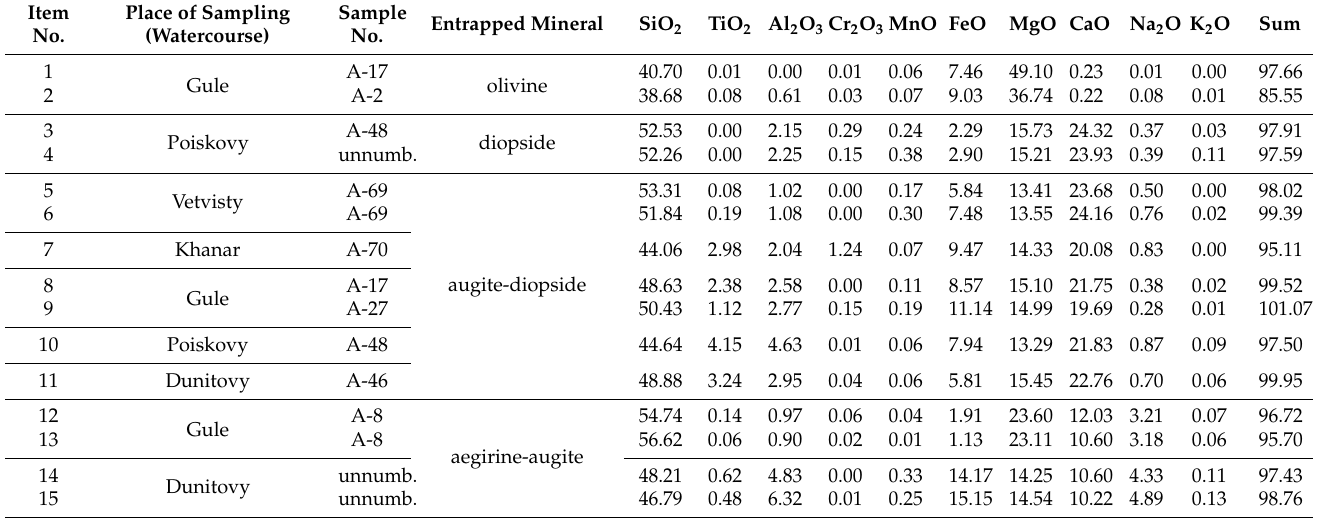
Table 5. Chemical composition of the minerals entrapped in gold, wt.